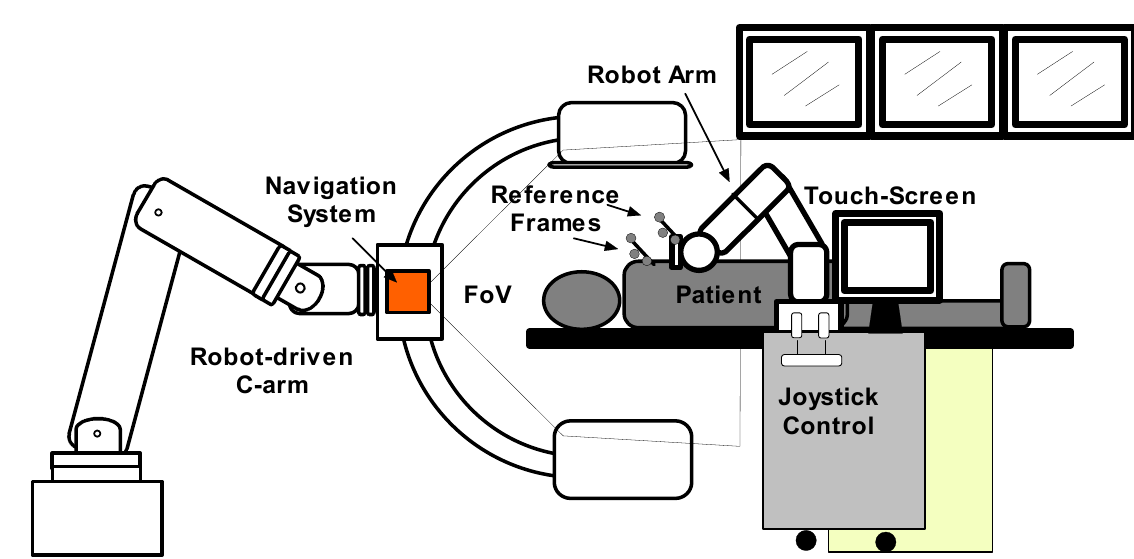
Figure 1. Sketch of a fully integrated system for percutaneous procedures.